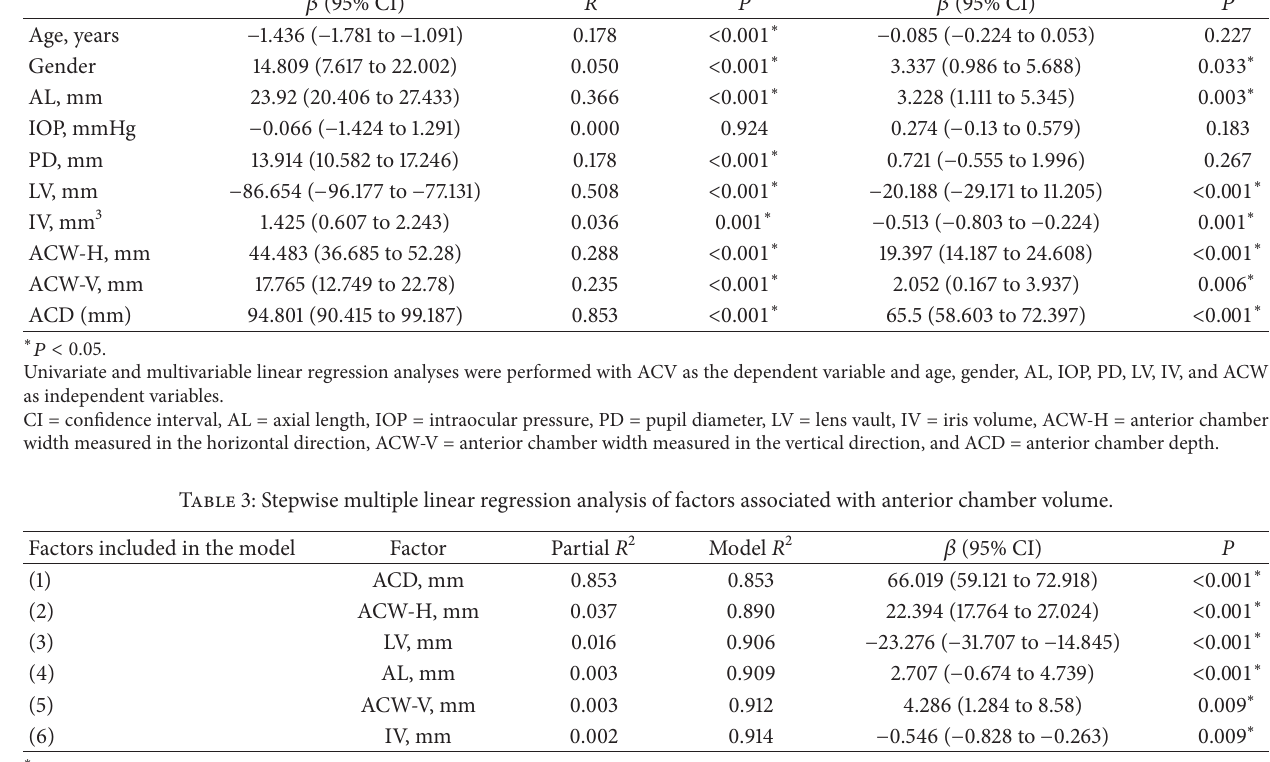
Table 2: Univariate and multivariate analyses of the associations between anterior chamber volume and ocular or general characteristics. Univariate analyses Multivariable analyses